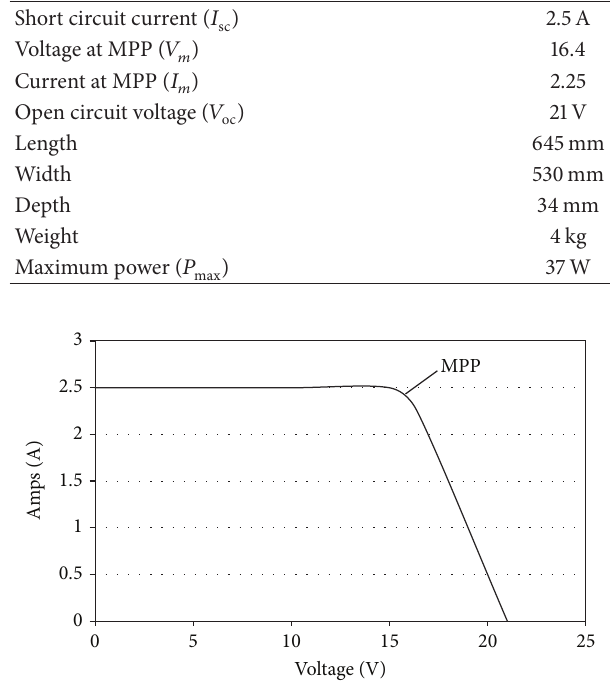
Figure 4: 𝑉 - 𝐼 characteristics of L 1235-37W solar